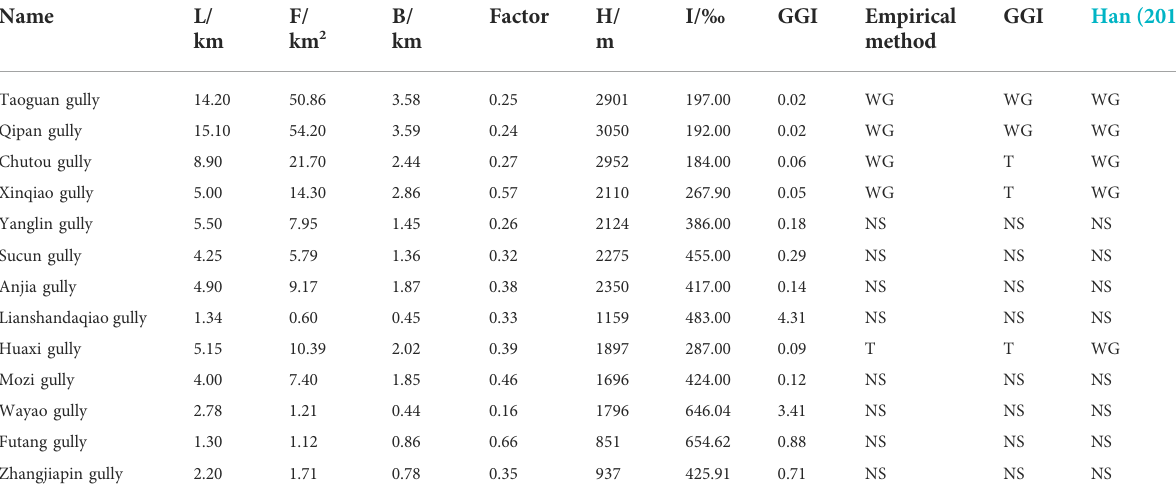
TABLE 3 Veri fi cation of Discrimination Results of Empirical method and